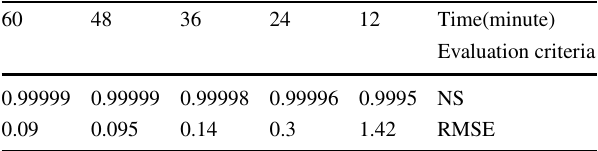
Table 1 Calculation of RMSE and NS at different times for soil suc- tion profile (m)